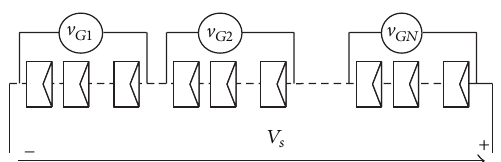
Figure 1: Structure of a PV string and the connected voltage sensors on each group.